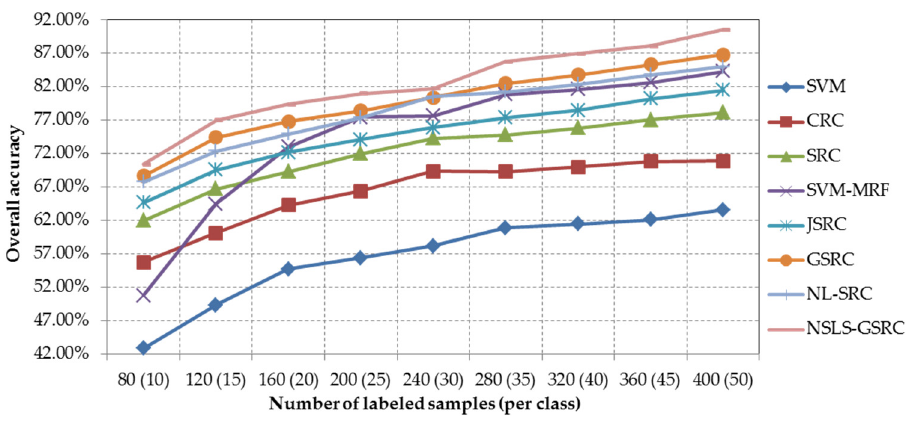
Figure 5. Overall classification accuracy obtained by the different tested methods versus different number of labeled samples for the AVIRIS Indian Pines scene. Table 2. Overall accuracies (in percent) obtained by the different tested methods using different number of labeled samples (per class) for the Indian Pines scene. The best results are in bold.